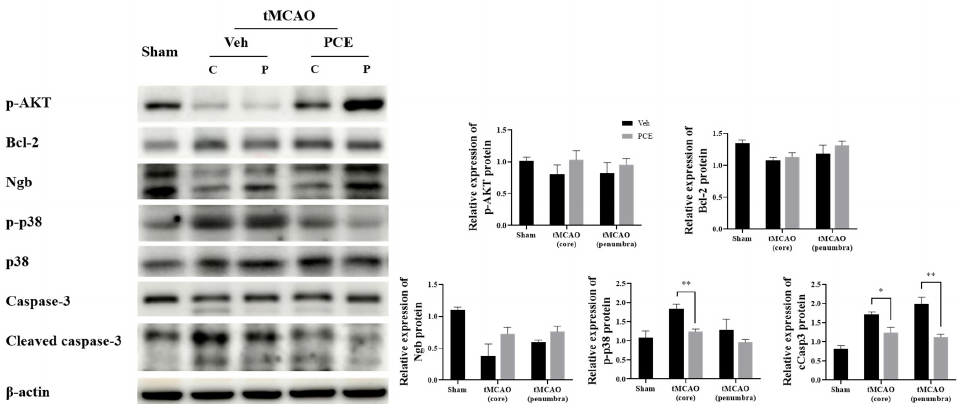
Figure 10. Changes are seen in the levels of prosurvival/apoptosis-associated molecules in the ischemic area due to PCE treatment. Expressions of antiapoptotic molecules p-AKT and Bcl-2 in the core region of ischemic stroke were higher in the PCE-treated tMCAO group than in the vehicle-treated tMCAO group. In the core and penumbra of the tMCAO vehicle-treated group, the expression of Ngb was decreased, and levels of activated p38 and cCasp3 were elevated; these effects were mostly reversed by PCE treatment. The mean values in triplicate experiments are presented along with SEM. Statistical significance was determined using the Holm–Sidak method ( n = 4), ** p < 0.01, * p < 0.05.